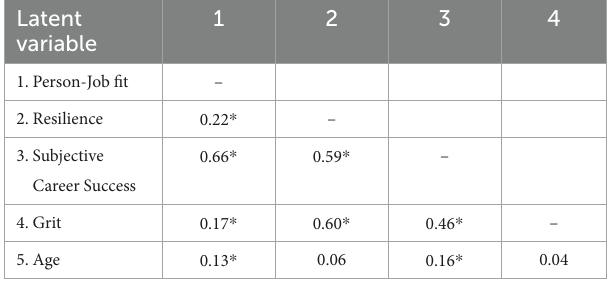
TABLE 4 Factor score